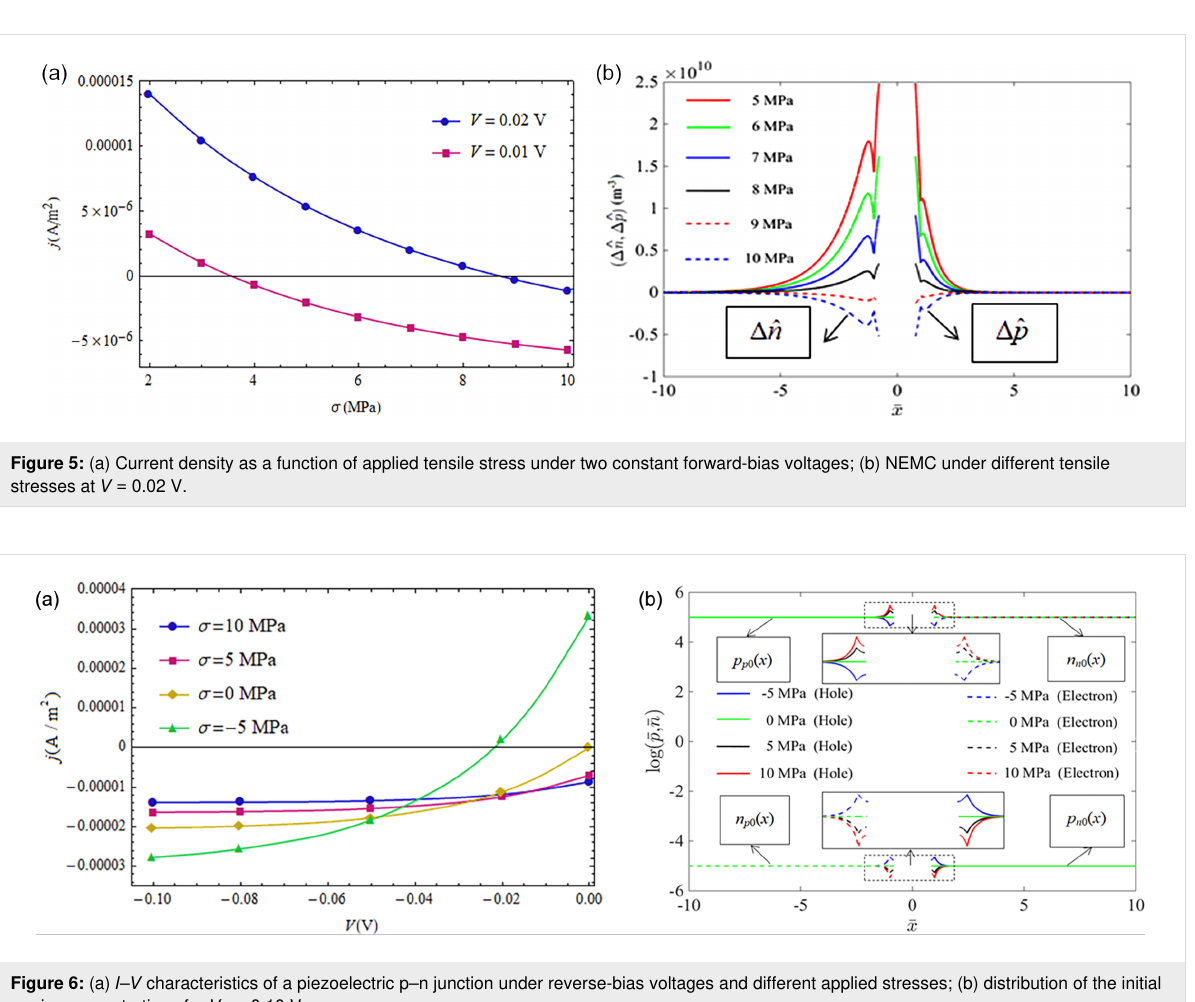
( p ̄ , n ̄ ) = ( p ( n 0, p 0) ( x ), n ( n 0, p 0) ( x ))/ n i . Finally, we note from Figure 6a an interesting phenomenon at V = 0.0 V that current density j s > 0 for a compressive loading and j s < 0 for a tensile loading, which comes from an equivalent forward- (reverse-) bias voltage on the SCZ produced by the mechanical